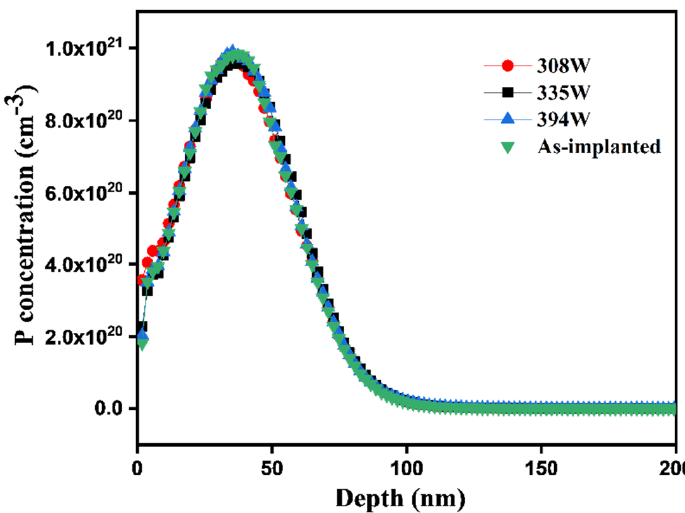
Figure 5. P concentration profiles of the as-implanted and annealed samples.